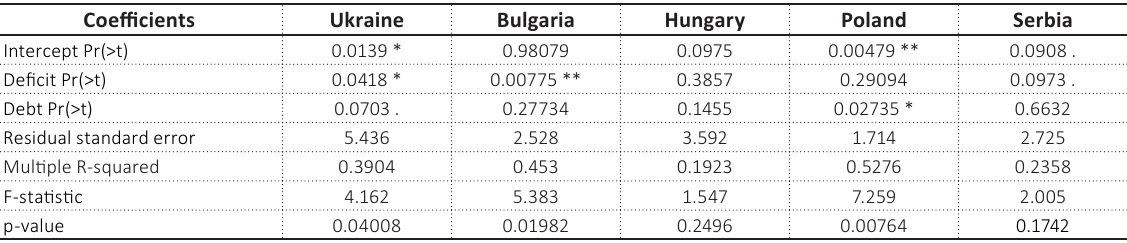
Table A7. Results of modelling for Hypothesis 1 (correlation between budget deficit, public debt and real GDP growth)